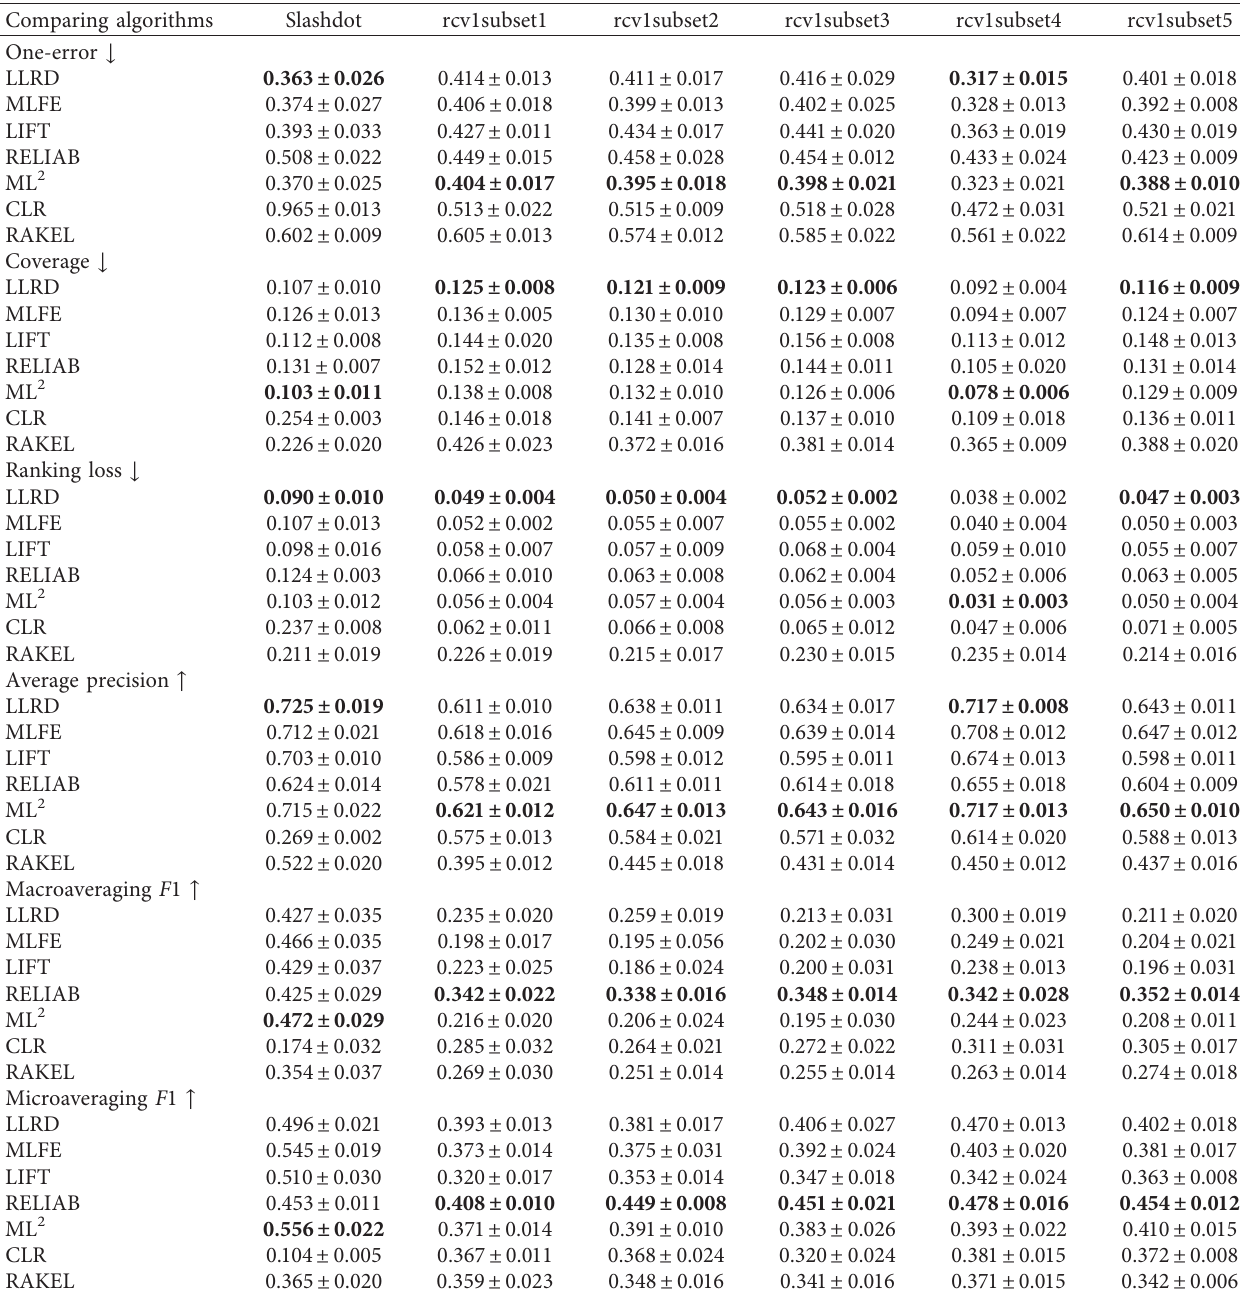
Table 3: Performance of each multilabel algorithm (mean ± std. deviation) on the large-scale datasets. Comparing algorithms